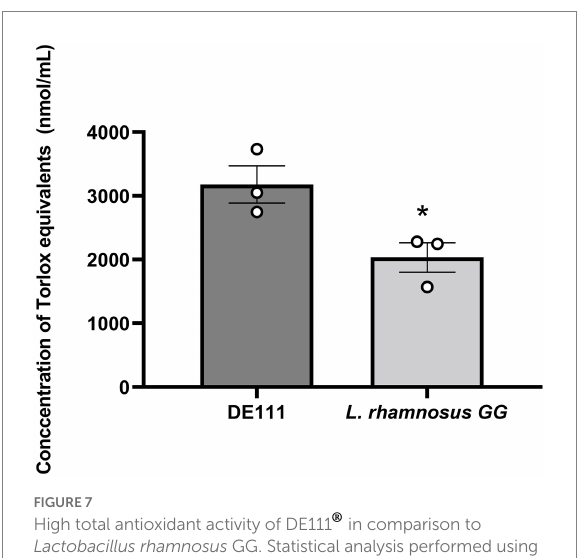
FIGURE 7 High total antioxidant activity of DE111 ® in comparison to Lactobacillus rhamnosus GG. Statistical analysis performed using unpaired T test and * p -value 0.037. Results show average concentration of Trolox equivalents in nmole/ml ( n = 3) ± standard